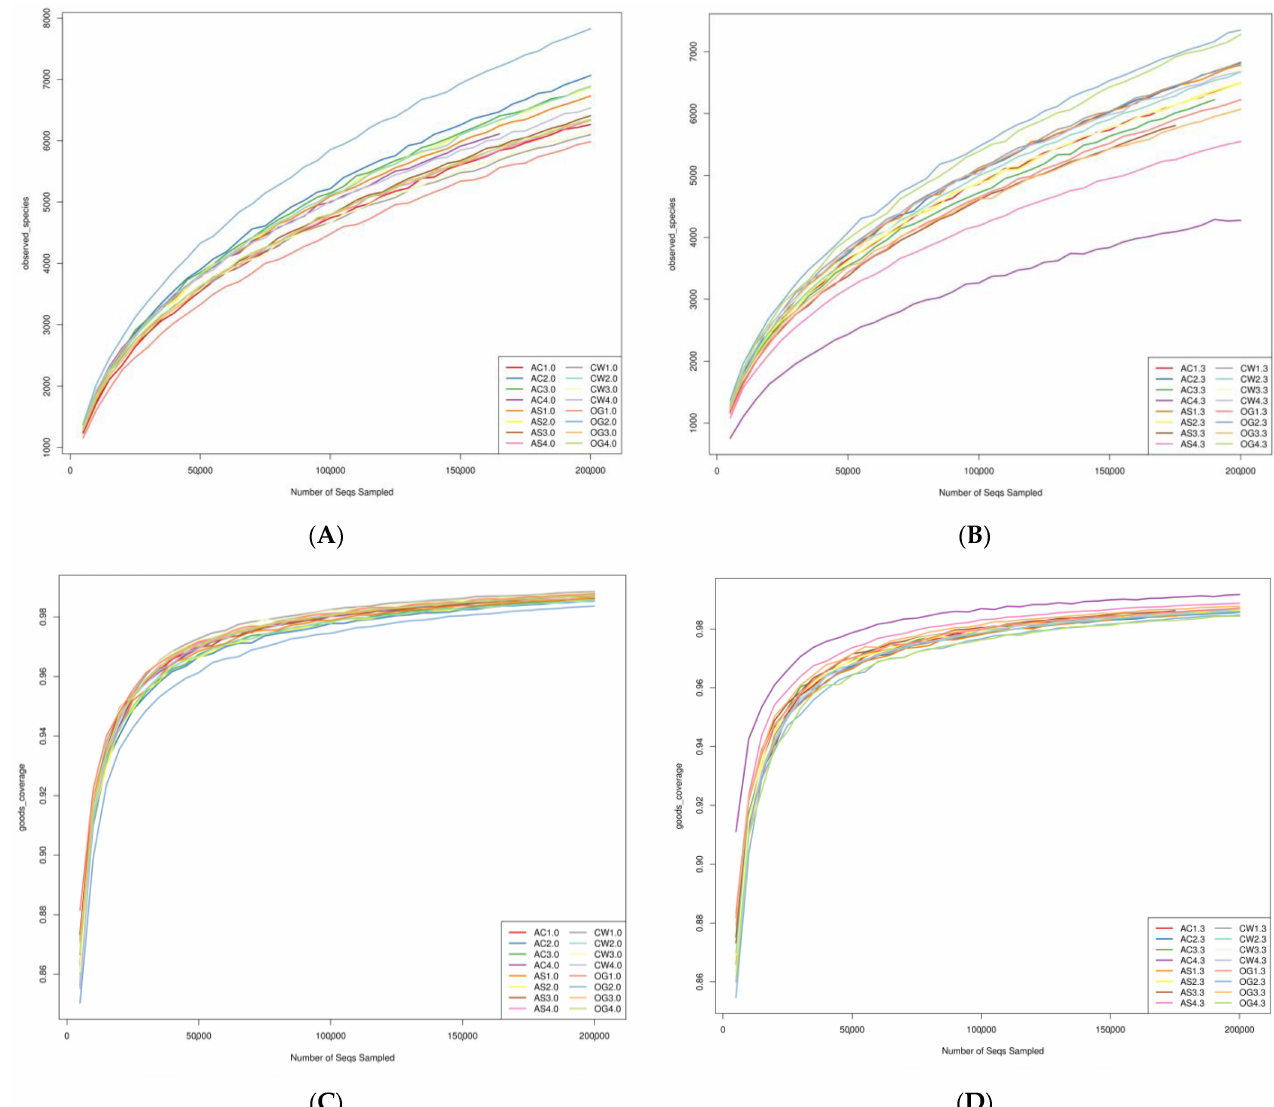
Figure 1. Rarefaction curves of microbes in different samples. (( A , C ) are 0 h; ( B , D ) are 3